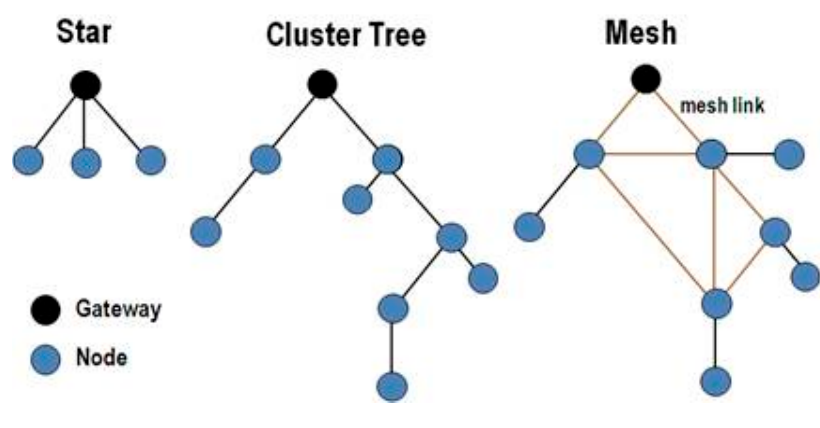
Figure 2. WSN Topologies.